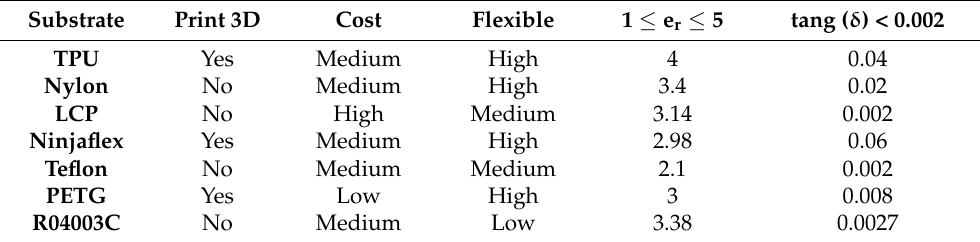
Table 4. Advantages and disadvantages of different flexible